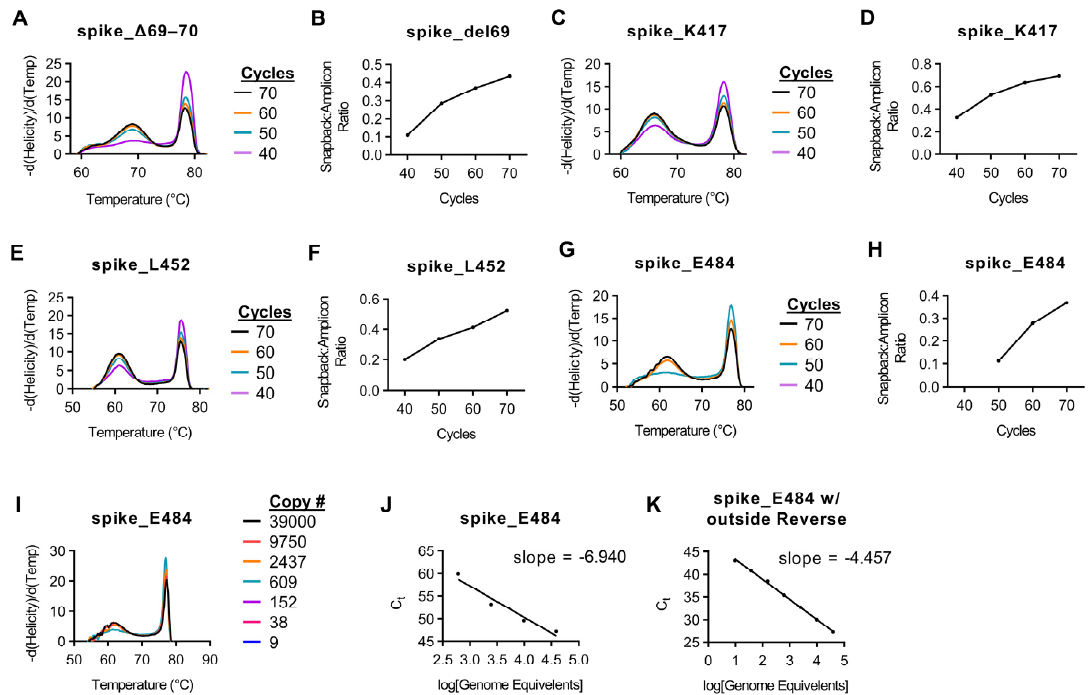
Figure 2. Effect of cycle number on snapback hybridization signal. Indicated SARS-CoV-2 genomic copy numbers were amplified using the protocol found in Materials and Methods with the cycle number varied. ( A ) Melt curves for the Figure 1. Standard curves for variant snapback HRM assays. Indicated SARS-CoV-2 genomic copy spike_del69–70 assay with indicated cycle numbers prior to HRM. ( B ) Snapback primer peak signal to main amplicon numbers were amplified using the protocol found in Materials and Methods. ( A ) Melt curves for peak signal relative to cycle number for the spike_del69–70 assay. ( C ) Melt curves for the spike_K417 assay with indicated the spike_del69–70 assay with indicated copy number numbers. ( B ) Ct values for the spike_del69– cycle numbers prior to HRM. ( D ) Snapback primer peak signal to main amplicon peak signal relative to cycle number for 70 assay relative to copy number. ( C ) Melt curves for the spike_K417 assay with indicated copy the spike_K417 assay. ( E ) Melt curves for the spike_L452 assay with indicated cycle numbers prior to HRM. ( F ) Snapback number numbers. ( D ) Ct values for the spike_K417 assay relative to copy number. ( E ) Melt curves primer peak signal to main amplicon peak signal relative to cycle number for the spike_L452 assay. ( G ) Melt curves for for the spike_L452 assay with indicated copy number numbers. ( F ) Ct values for the spike_L452 the spike_E484 assay with indicated cycle numbers prior to HRM. ( H ) Snapback primer peak signal to main amplicon assay relative to copy number. peak signal relative to cycle number for the spike_E484 assay. ( I ) Melt curves for the spike_E484 assay with indicated copy number numbers. ( J ) Ct values for the spike_E484 assay relative to copy number. ( K ) Ct values for the spike_E484 assay with the addition of an outside reverse primer relative to copy